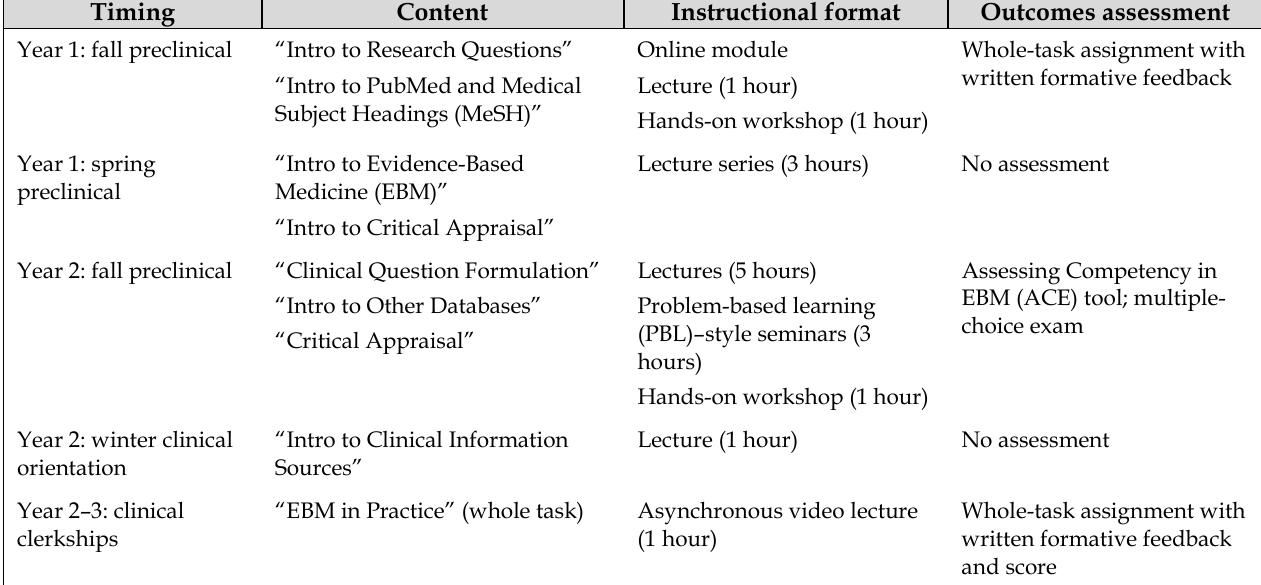
Table 1 Evidence-based medicine (EBM) curriculum